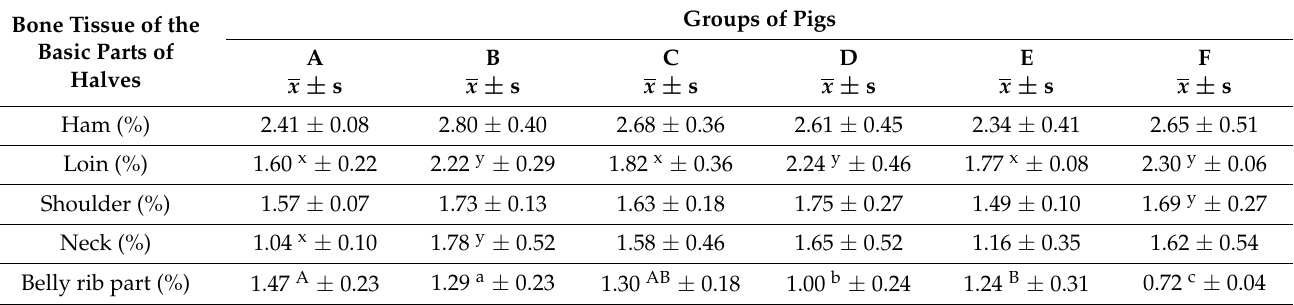
Table 8. Shares of bone tissue of the basic parts in the weight of pig